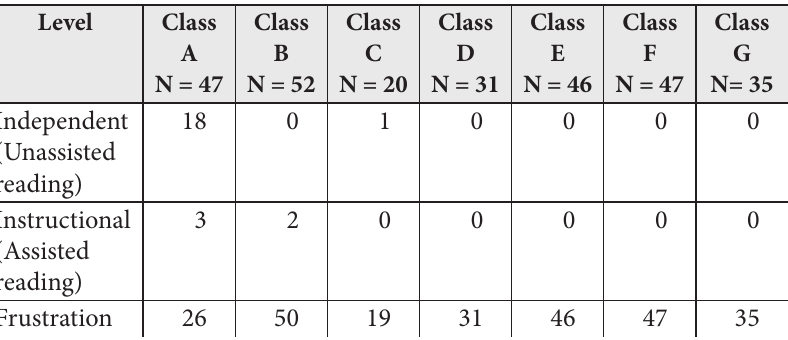
Table 1: Number of children by category of